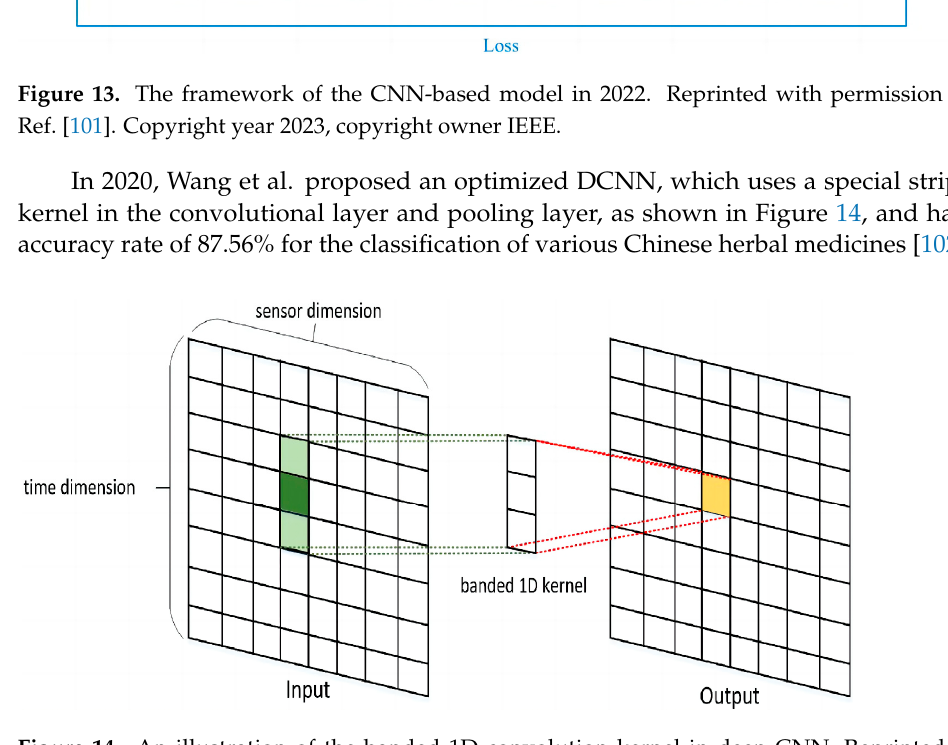
Figure 14. An illustration of the banded 1D convolution kernel in deep CNN. Reprinted with